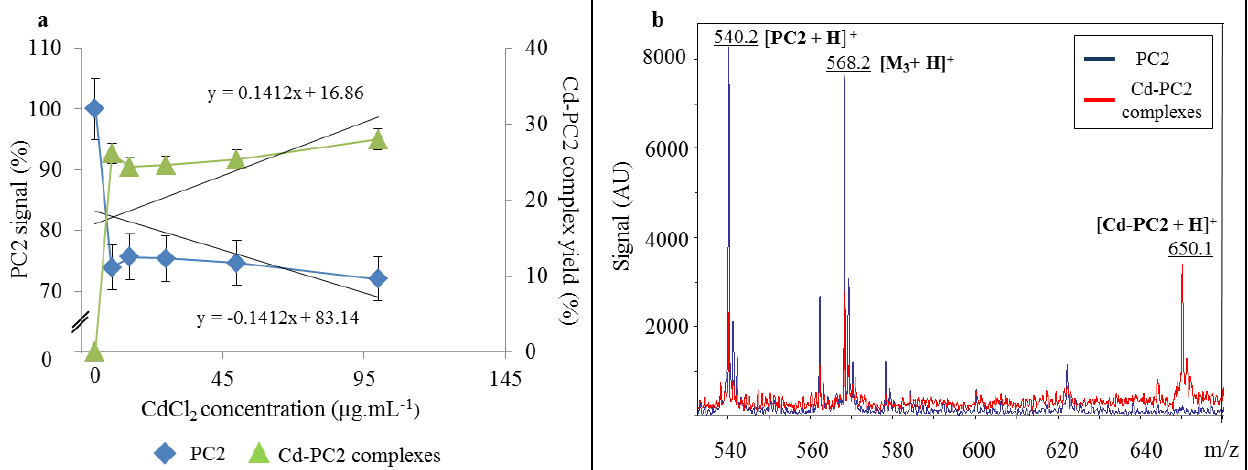
Figure 4. ( a ) Diagram of change in the signal of PC2 (%) and yield of Cd-PC2 complex (%) as function of CdCl concentrations determined by IEC. ( b ) Mass spectra of PC2 (blue 2 line) and Cd-PC2 complexes (red line) in CCA matrix measured by